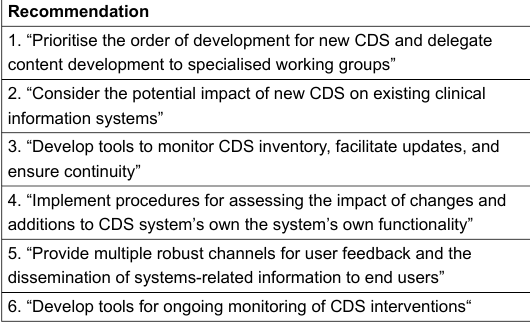
Table 2: Summary of the 10 commandments for effective clinical decision support by Bates et al. [51].